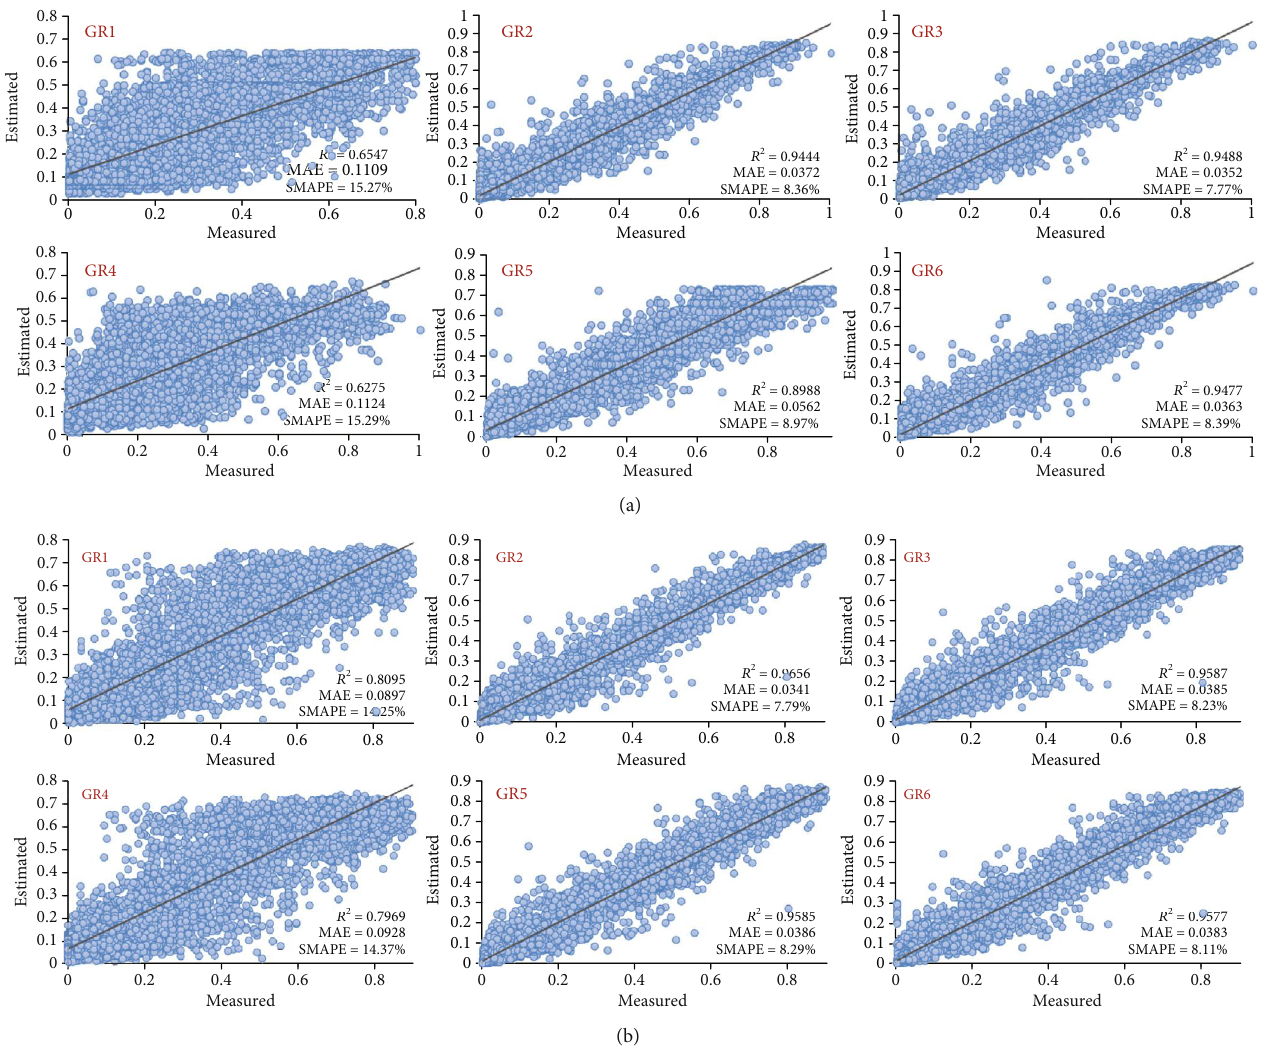
Figure 10: SR estimation scatter plots of MFFNN models for (a) Isparta and (b) Kahramanmaras according to test input